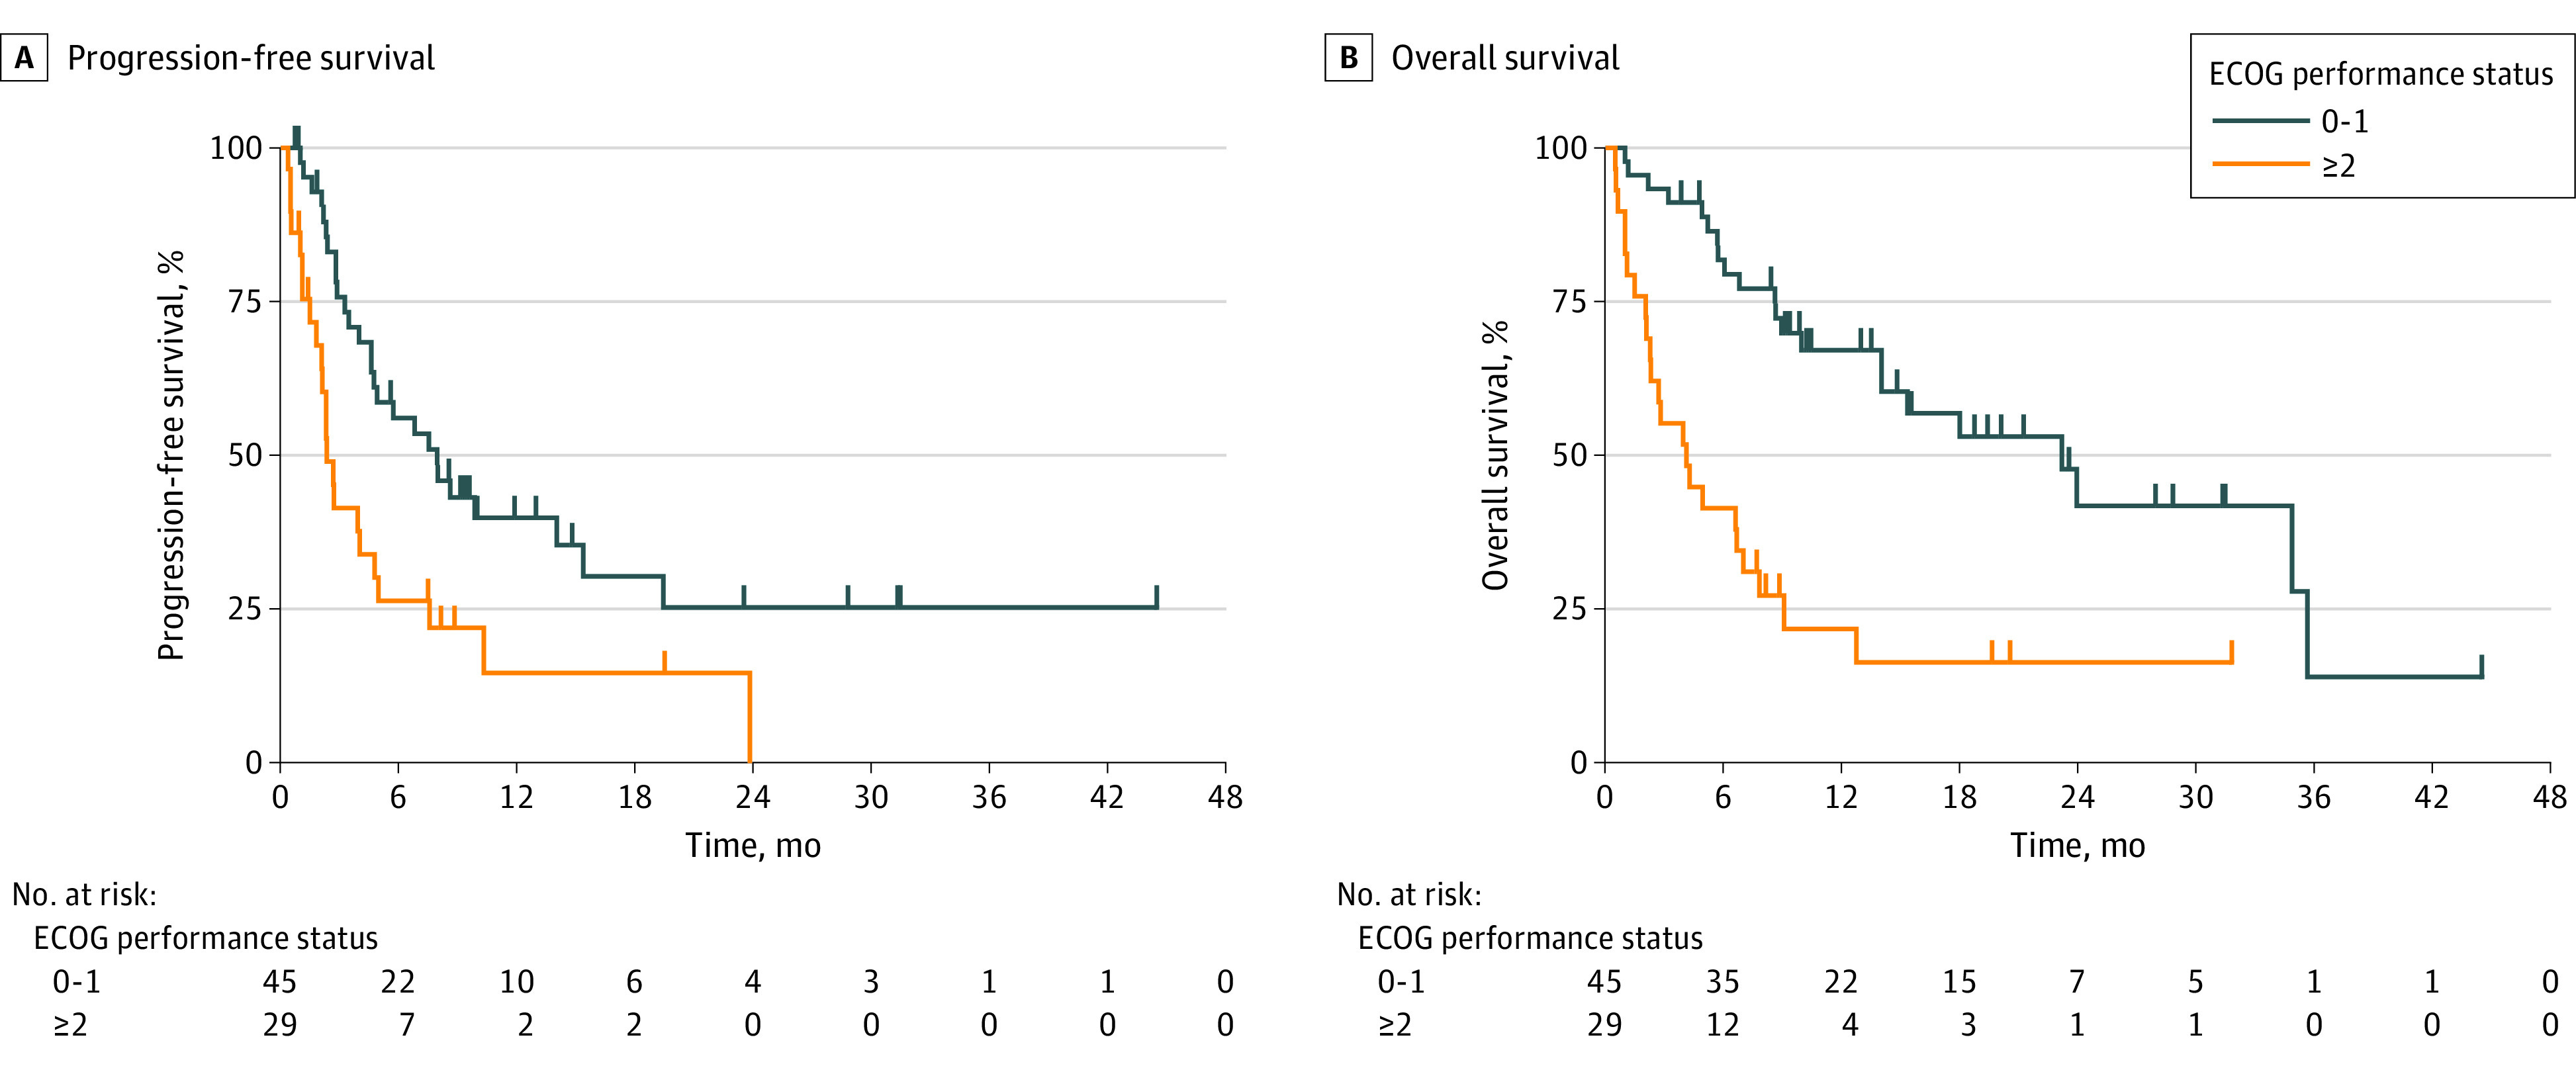
Outcomes by Performance StatusECOG indicates Eastern Cooperative Oncology Group.